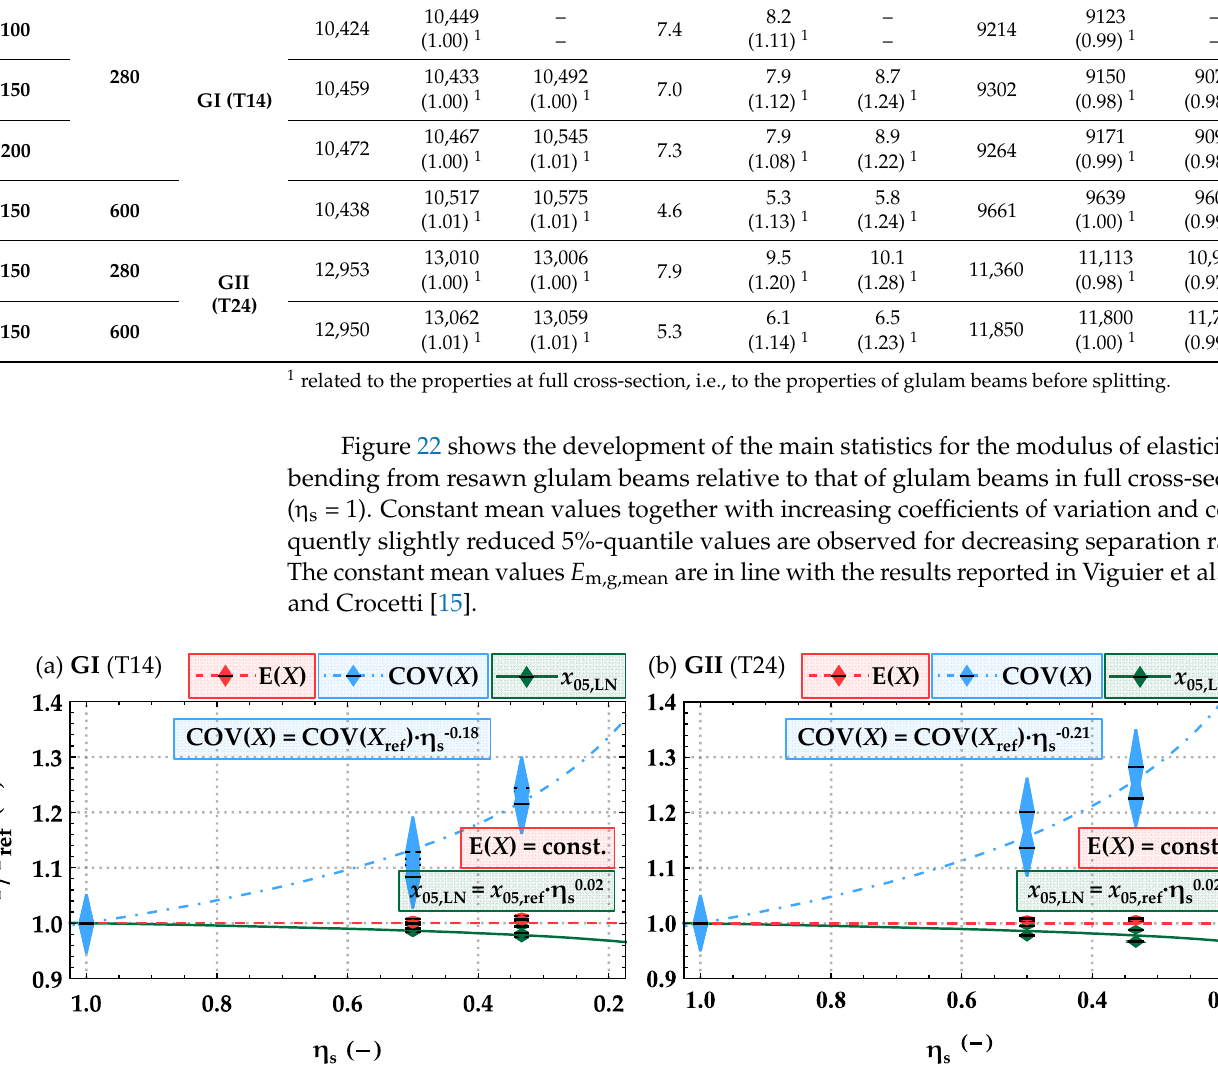
Table 13. Main statistics of the modulus of elasticity E m,g from 10 3 simulated glulam beams and resawn glulam {1 cut; 2cuts} for each parameter setting featuring various widths w g = {100; 150; 200} mm, depths h g = {280; 600} mm and base material GI (T14) and GII (T24).